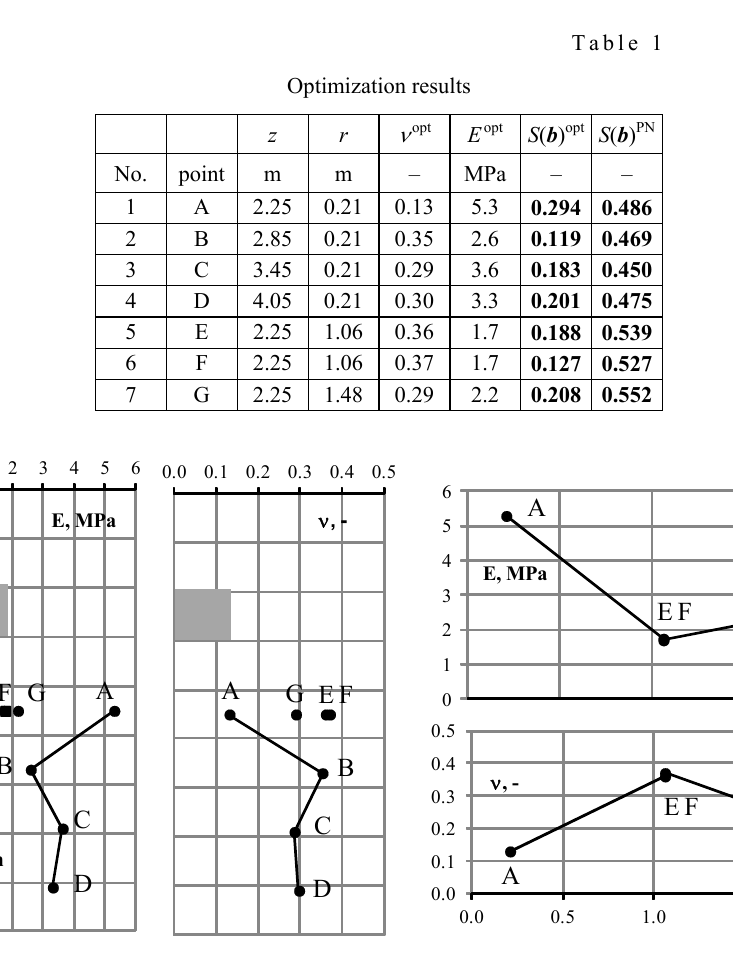
Fig. 3. Optimal values of E &  depending on depth ( z ) and distance from the pad foundation ( r